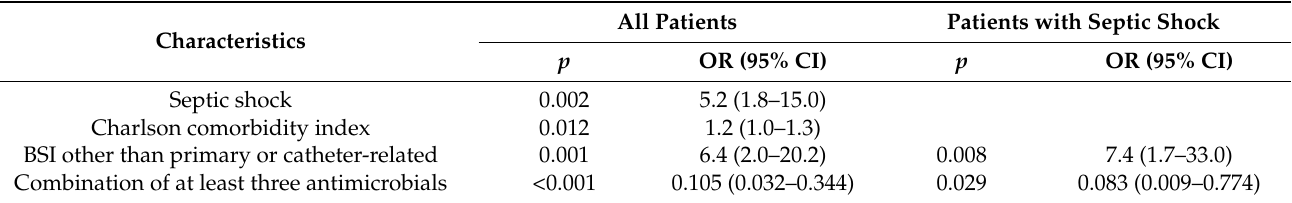
Table 2. Multivariate analyses of predictors of 14-day mortality in patients with bloodstream infection (BSI) during intensive care unit (ICU) hospitalization.